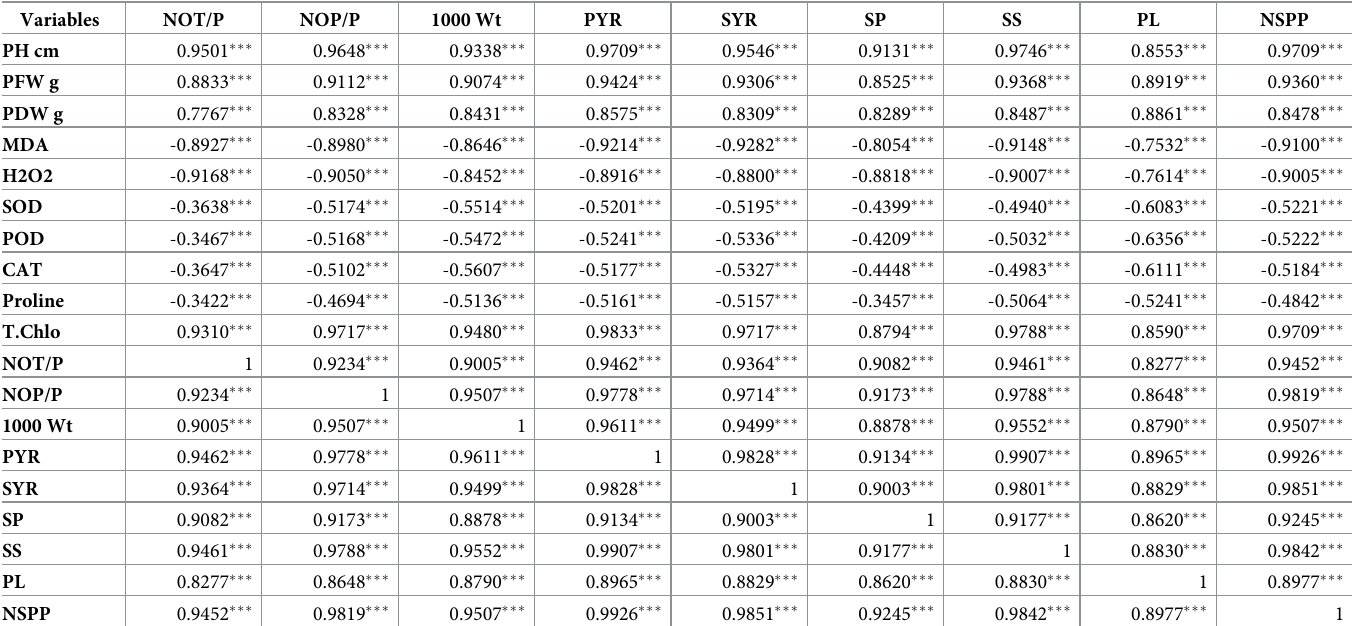
Table 3. Spearman correlation matrix for studied variables and yield attributes of rice plants raised from ZnONPs primed seeds.